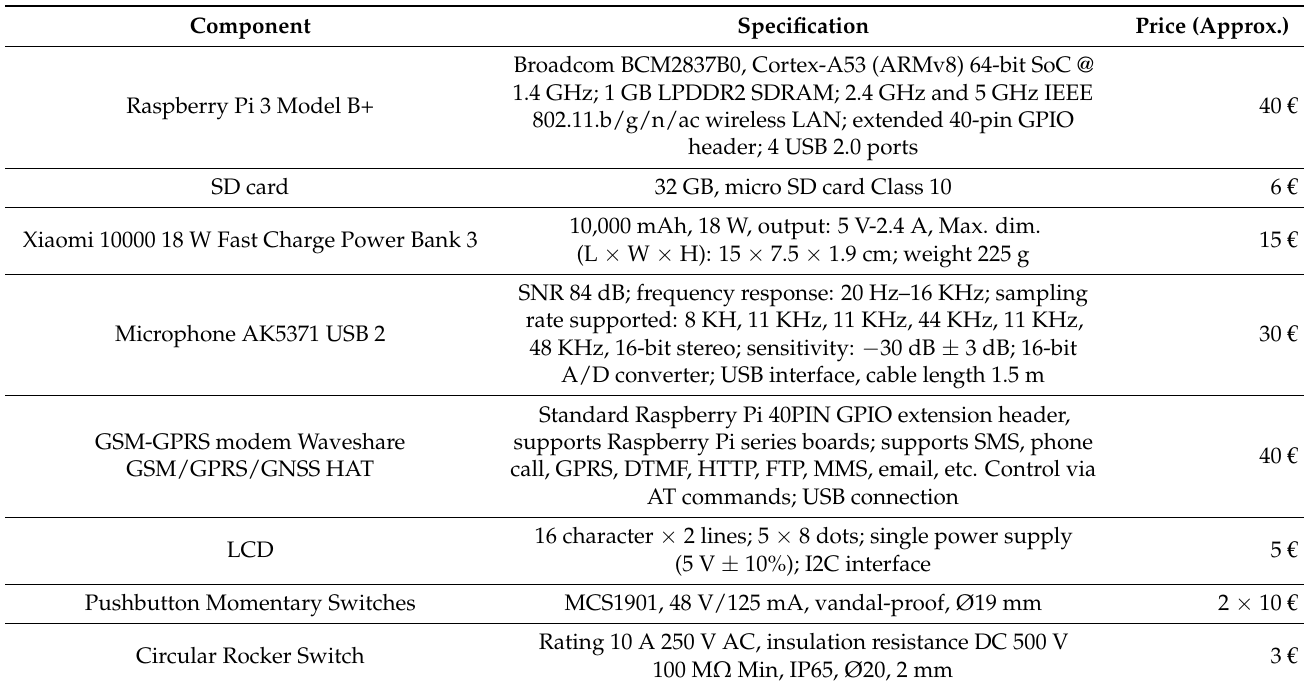
Figure 8. Portable device for acoustic signal acquisition and processing. Table 2. Specification of components used for the design of the portable device from Figure 8.